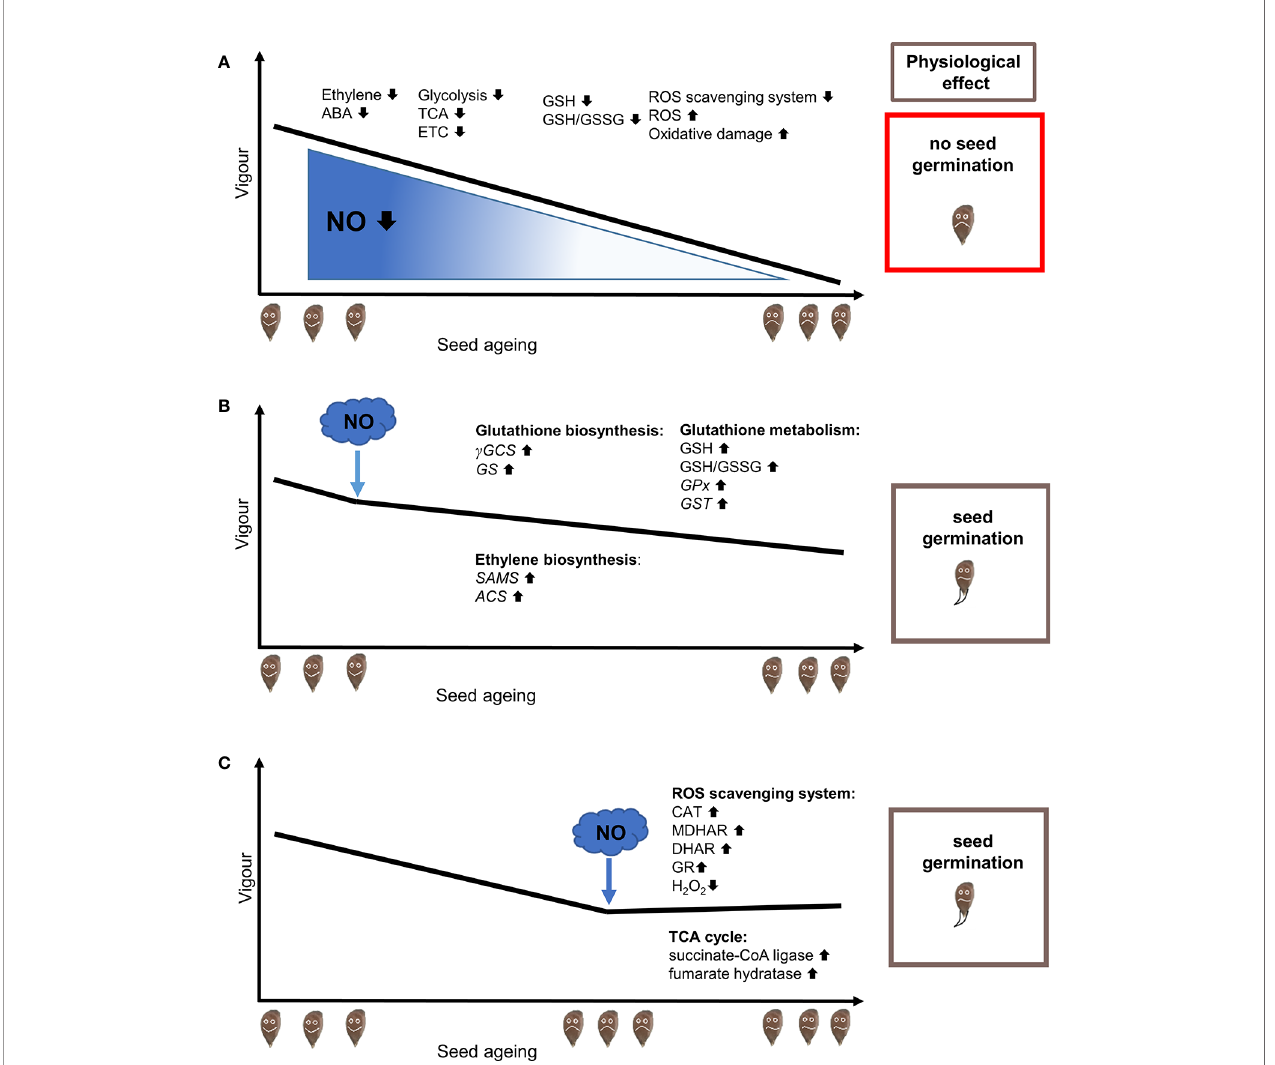
FIGURE 1 | RNS application to maintain seed quality in aged seeds subjected to controlled deteriorated treatment (CDT) mitigates reduction of endogenous NO level. (A) A decrease in seed vigor during the aging process is induced by CDT. Seed aging is linked to ROS accumulation, due to impaired ROS generation and ROS scavenging by the antioxidant system, decreased GSH pool and GSH/GSSG ratio (Bailly et al., 2008; Ratajczak et al., 2019), disturbances in phytohormonal balance — decreased ethylene and ABA level (Sano et al., 2016) and down-regulation of the proteins involved in glycolysis, tricarboxylic acid (TCA) cycle, the electron transport chain (ETC) and oxidative phosphorylation (Xin et al., 2011). (B) The application of nitric oxide (NO) or NO donors before CDT activates protecting mechanisms that prevent the reduction of seed vigor. NO pre-treatment of the seeds subjected to CDT improves their quality by (i) increasing of GSH level and GSH/ GSSG ration, (ii) up-regulation of the expression of genes encoding g -glutamylcysteine synthetase ( g GCS), glutathione synthetase (GS), glutathione S -transferase (GST), glutathione peroxidase (GPx), (iii) stimulation of methionine metabolism due to up-regulation of the transcription of the genes encoding S -adenosyl-L- methionine synthetase (SAMS) and 1-aminocyclopropane-1-carboxylic acid synthase (ACS) enzymes of ethylene biosynthetic pathway (He et al., 2018). (C) The application of NO or NO donors during CDT improves seed vigor by inducing processes that lead to the initiation of repair of oxidative damages, mainly in mitochondria. NO stimulates (i) activity of enzymatic antioxidant system in mitochondria: catalase (CAT), glutathione reductase (GR), monodehydroascorbate reductase (MDHAR), dehydroascorbate reductase (DHAR) (ii) leading to decreased H 2 O 2 content in aged seeds, (iii) improves also mitochondrial function in aged seeds by enrichment of some proteins of TCA cycle: succinate-CoA ligase (ADP-forming) subunit and fumarate hydratase (Mao et al.,